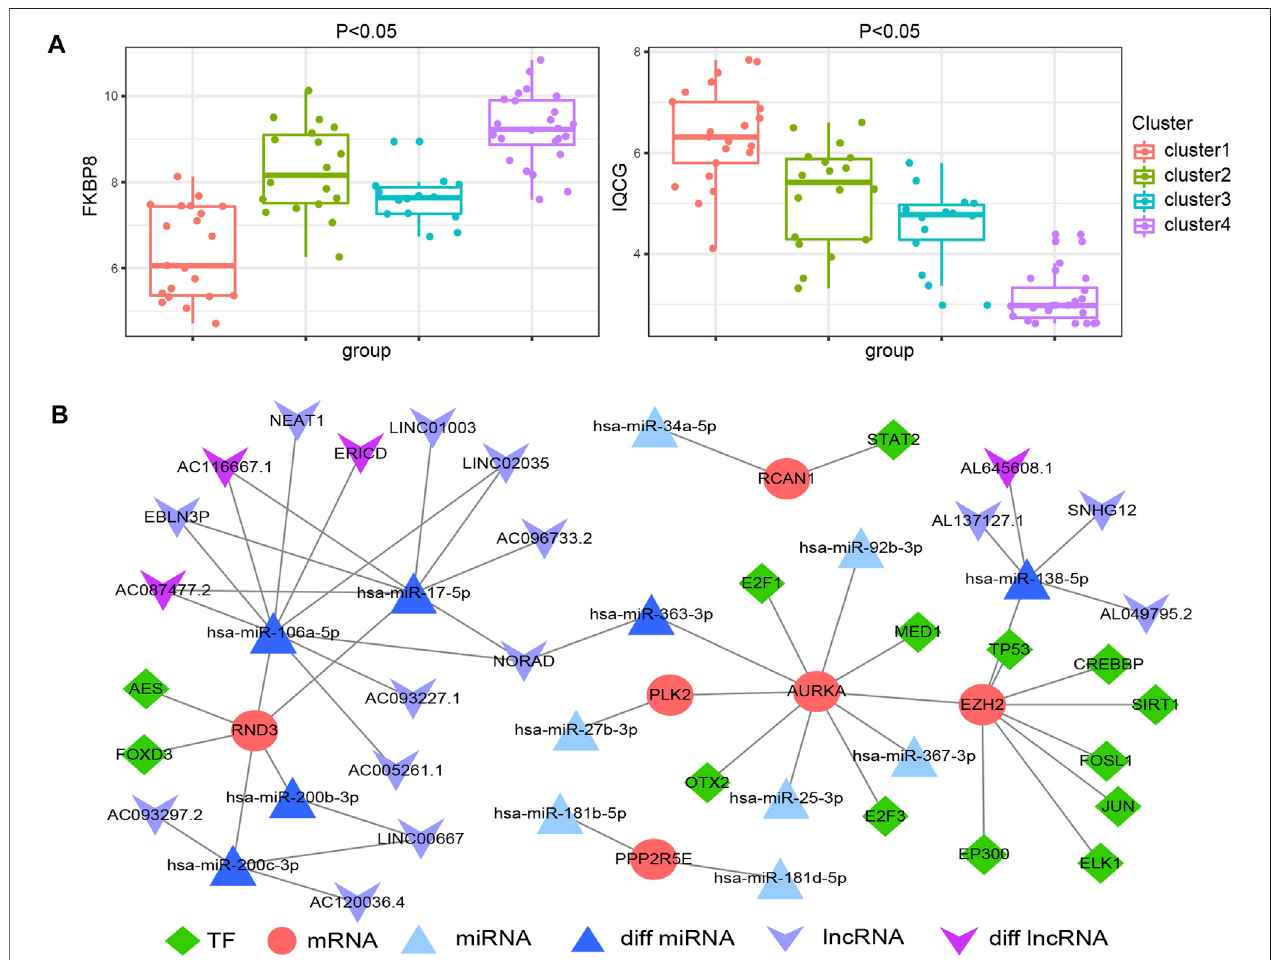
FIGURE 5 | Differential expression of FKBP8 and IQCG in the four new subgroups of endometriosis (A) . Construction of the multifactorial network in endometriosis (B) .